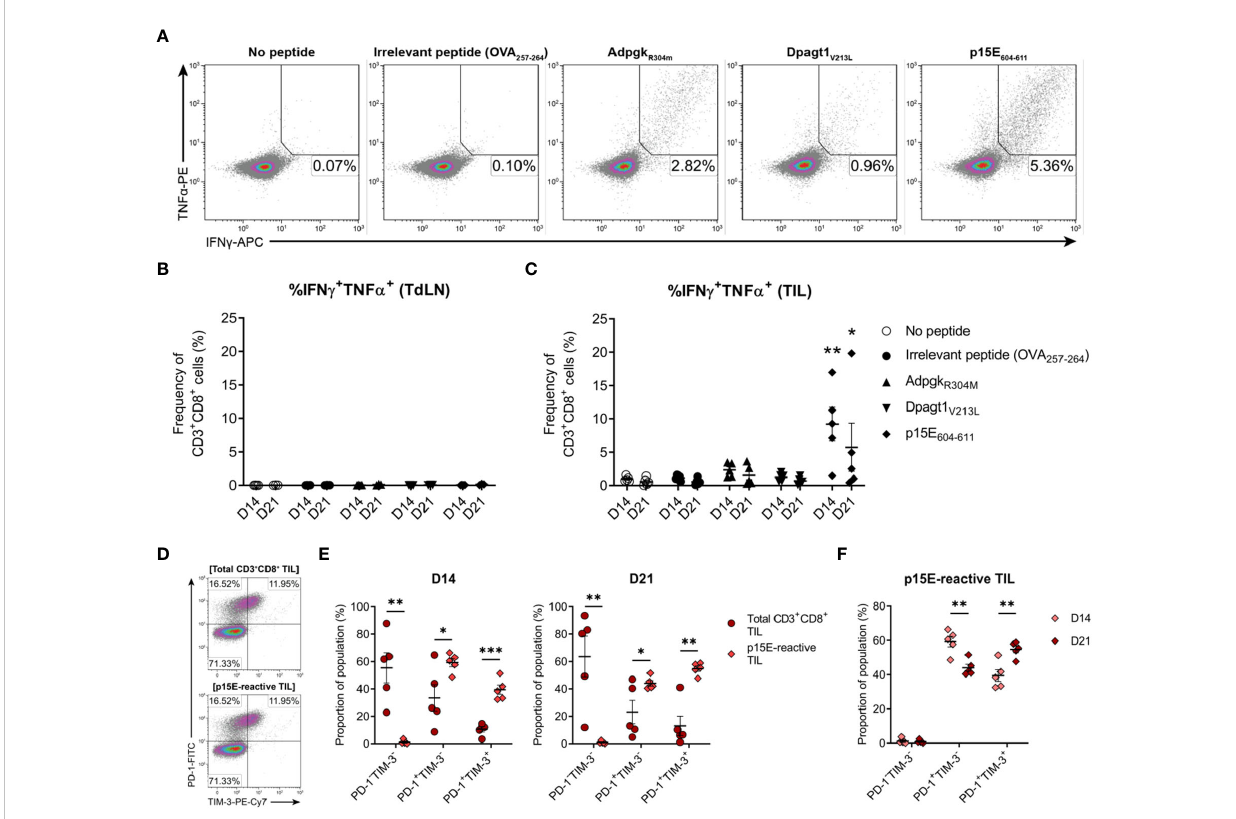
FIGURE 10 The endogenous CD8 + T cell response to MC38 is dominated by recognition of the p15E tumour antigen. (A) Representative density plots showing TNF a and IFN g production by CD8 + TILs stimulated ex vivo with BMDCs pulsed with 1 µg/mL of H-2K b /D b -restricted tumour antigen peptides (p15E 604-611 , KSPWFTTL; Adpgk R304M, ASMTNMELM; and Dpagt1 V213L , SIIVFNLL), unpulsed BMDCs (no peptide) or BMDC pulsed with 1 µg/mL OVA 257 – 264 peptide (SIINFEKL; irrelevant peptide). Percentages indicate peptide-reactive CD8 + T cell frequencies (%IFN g + TNF a + ) as the proportion of total CD3 + CD8 + cells. (B, C) Frequency of polyfunctional CD3 + CD8 + cells – isolated from TdLNs (B) and TILs (C) – producing IFN g and TNF a in response to indicated treatments (%IFN g + TNF a + ). (D) Representative density plots showing PD-1 and TIM-3 expression by total CD3 + CD8 + TILs (top) and p15E-reactive CD3 + CD8 + TILs (IFN g + TNF a + , bottom) isolated from D21 MC38 tumours. Percentages indicate subset frequencies as the proportion of the gated populations. (E) Comparison of PD-1 and TIM-3 subset compositions in total CD3 + CD8 + TILs ( (cid:129) ) and p15E-reactive CD3 + CD8 + TILs ( ♦ ) from D14 and D21 MC38 tumours. (F) Comparison of PD-1 and TIM-3 subset compositions in p15E-reactive CD3 + CD8 +